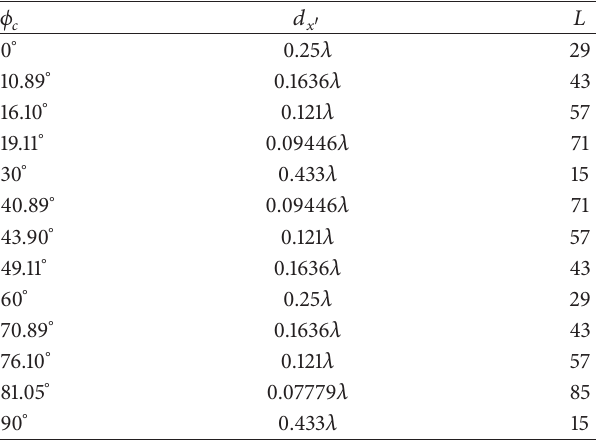
Table 1: Collapse angles for triangular grid arrays. 𝐿 is the number of elements for the proposed 169-element